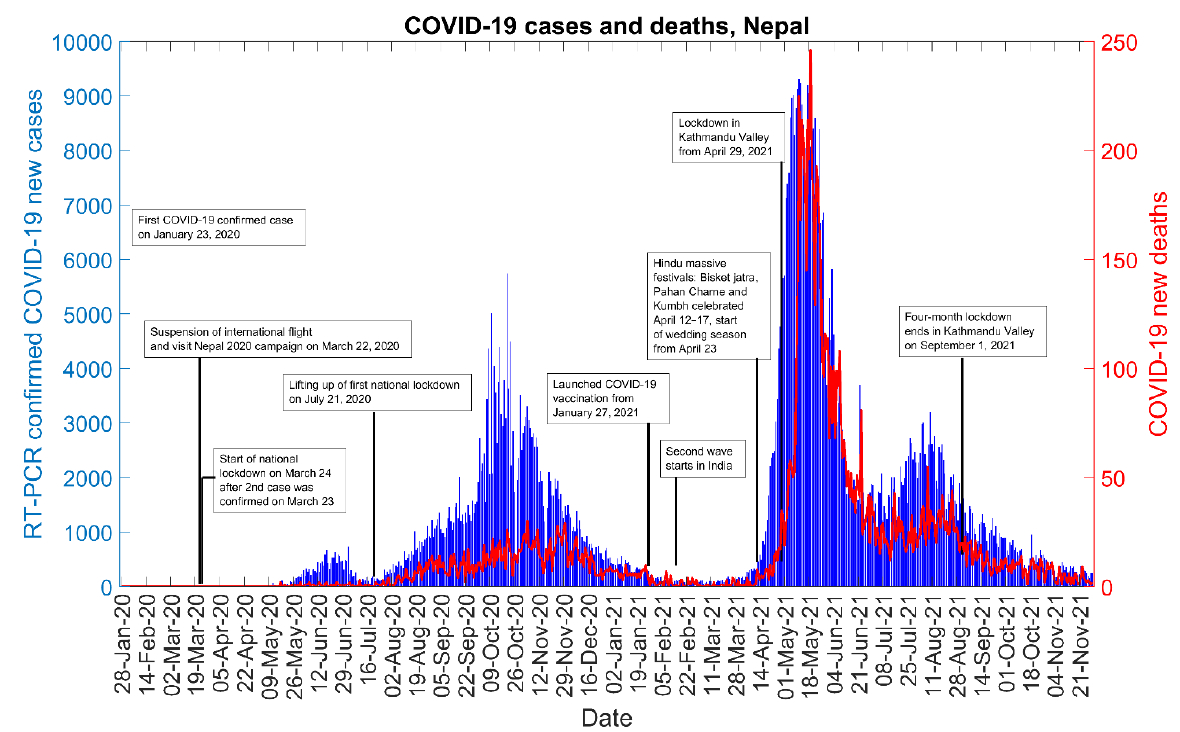
Figure 1. Epidemic curve of the COVID-19 pandemic in Nepal as of 30 November 2021.